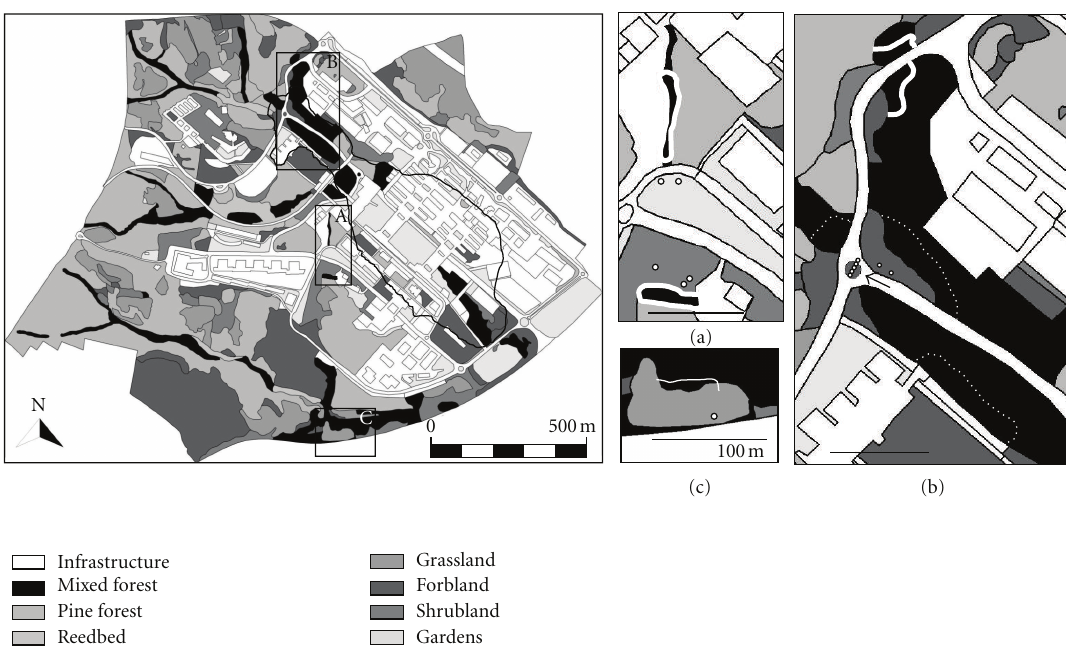
Figure 1: The University campus is composed by three main units. The first unit comprises all the university and transportation infrastructure like buildings, parkings, railway stations, roads, and paths. The agroforestal unit is composed by natural areas such as mixed and pine forests, shrubland, grassland and reedbed. Finally, the gardened unit included grass areas with several isolated trees and bushes. The area of the campus invaded by L. neglectus is surrounded by a black line. On the right side, areas (a, b, and c) of the chosen invaded (dotted line) and control (continuous line) forest fragments have been enlarged. Isolated trees are shown with small white circles. The arrow, in figure (b) points a roundabout where there are five isolated trees colonized by L. neglectus